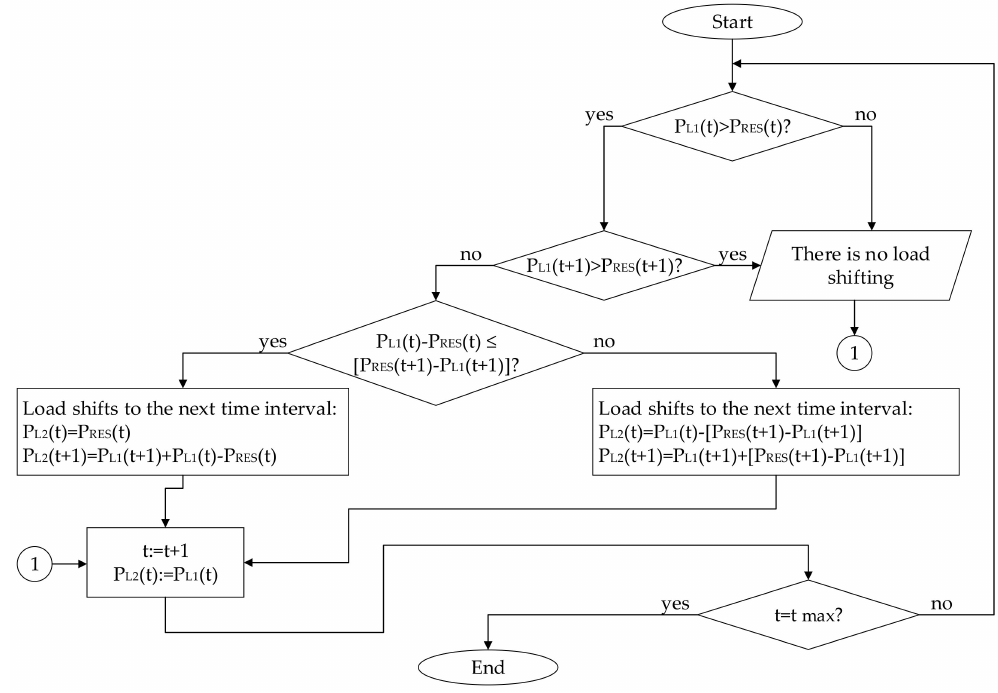
Figure 2. Load control algorithm with a load shifting of no more than 1 h